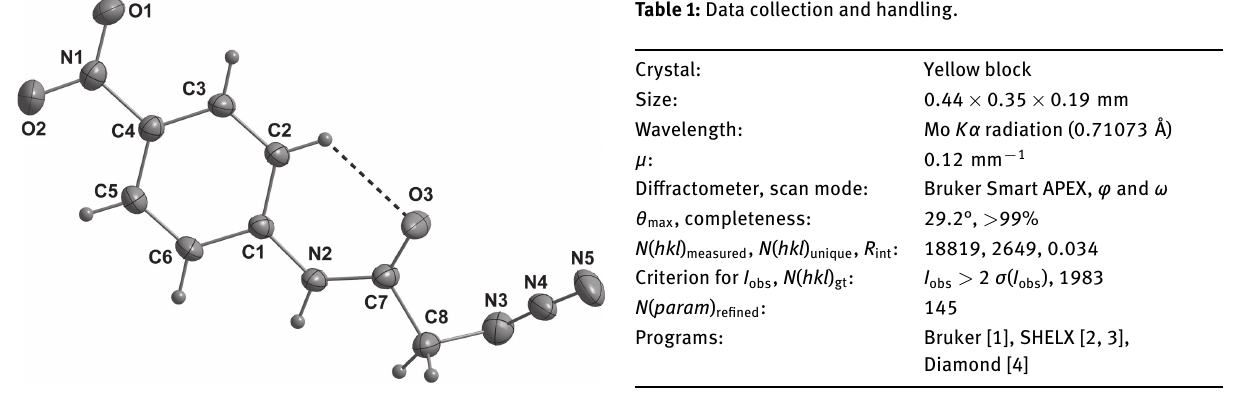
Table 1: Data collection and handling.